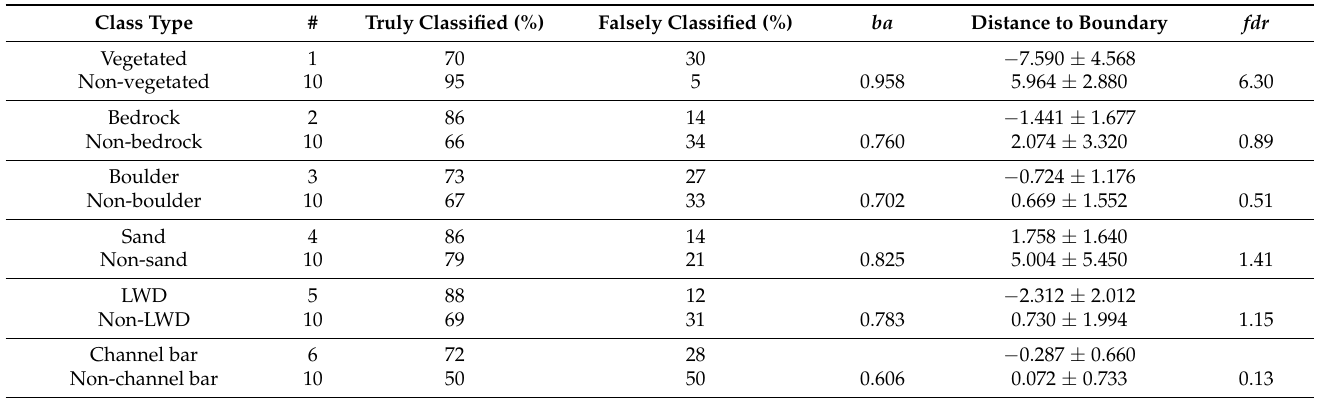
Table 3. Results for the geomorphic classification of natural channels. Values show the results of classifier files for a subset of 10,000 point cloud